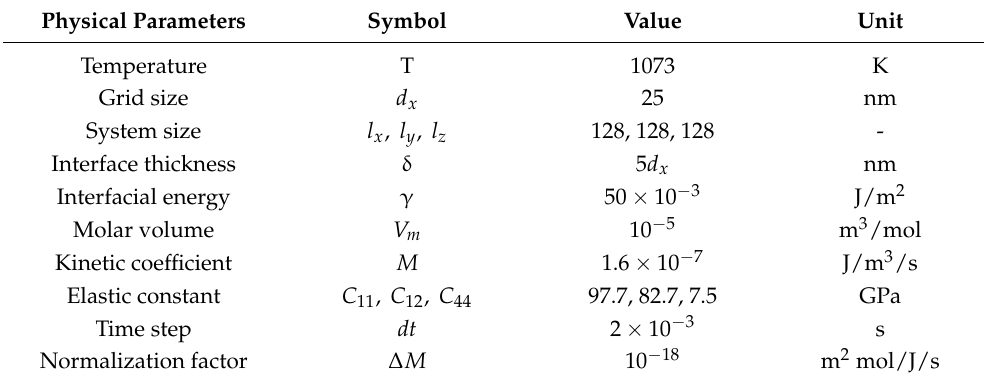
Table 7. Simulation parameters used in the phase field